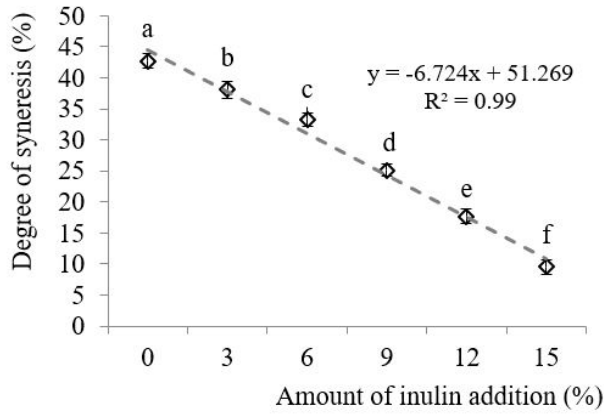
Figure 8. Degree of syneresis of yogurts with 0%, 3%, 6%, 9%, 12% or 15% w/w inulin addition measured using centrifugal method (a, b, c…—various letters for average values mean statistically significant differences, p < 0.05).